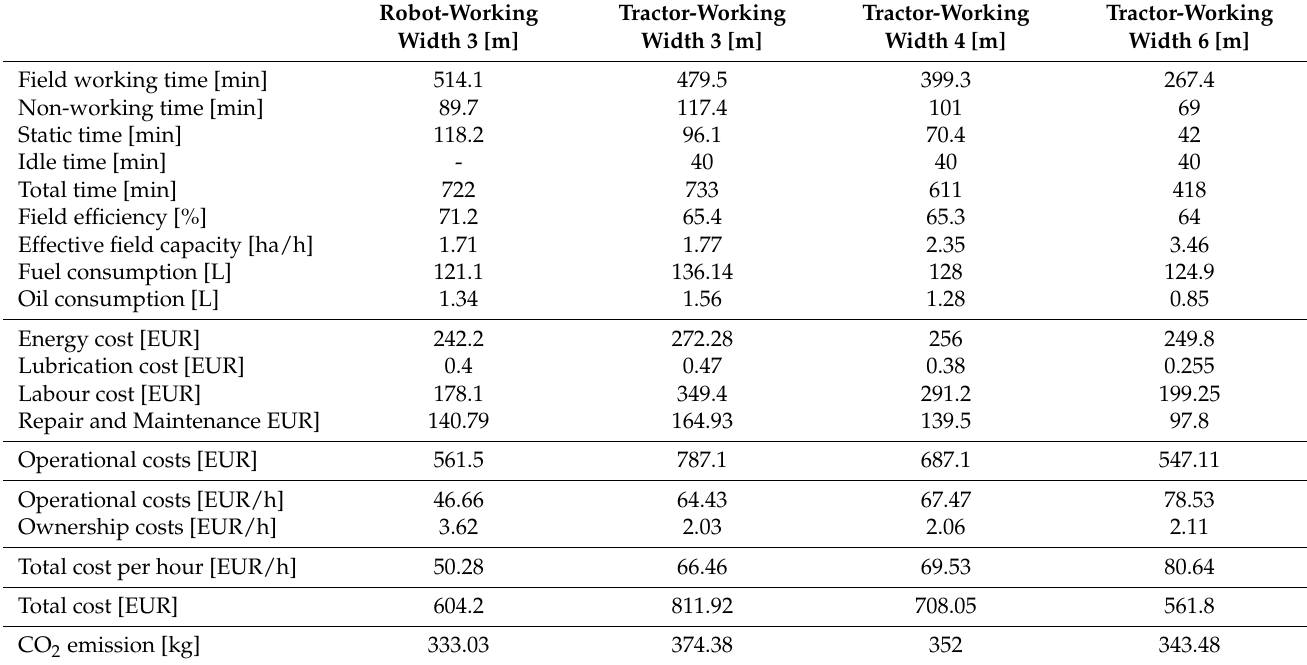
Table 12. The results of in-field operation in the third scenario for the robot and the tractor by considering 40 min break time for the